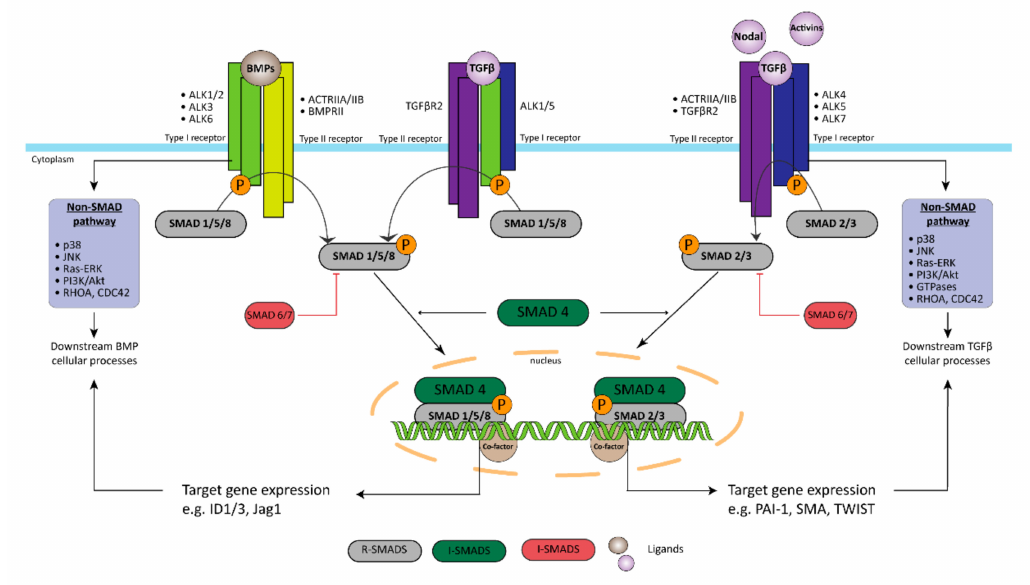
Figure 2. Transforming growth factor- β (TGF- β ) superfamily signaling in PAH. The bone morphogenetic protein (BMP)/TGF- β signaling pathway is an important factor in the existence of EC dysfunction in PAH. Decreased expression of BMPR2 but more importantly various mutations in the BMPR2/BMP-ligand axis are associated with specific changes in EC behavior such as increased proliferation and migration, but also structural changes that cause the loss of the protective EC barrier. In addition, the TGF- β superfamily signaling also plays an important role the initiation of EndoMT by triggering the overexpression of genes, like TWIST1, α SMA, and phospho-vimentin. Receptor-regulated Smads (R-Smads); Common mediator Smad (Co-Smad); Inhibitory Smads